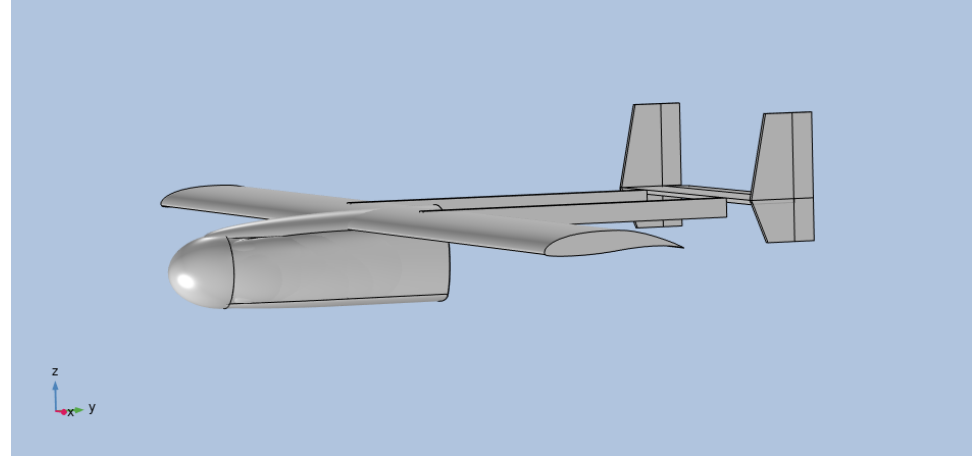
Figure 1. Unmanned Arial Vehicle (UAV) drawn